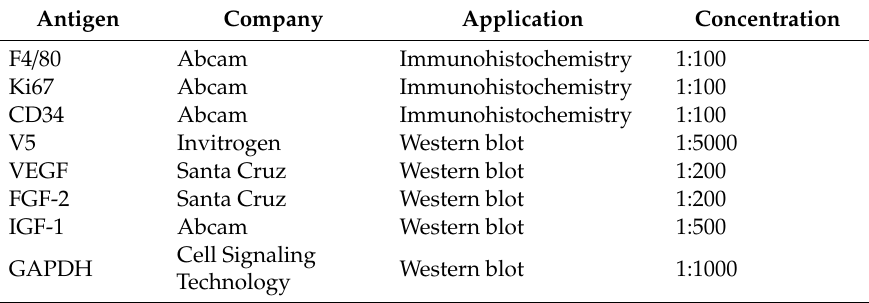
Table 2. The primary antibodies used for this